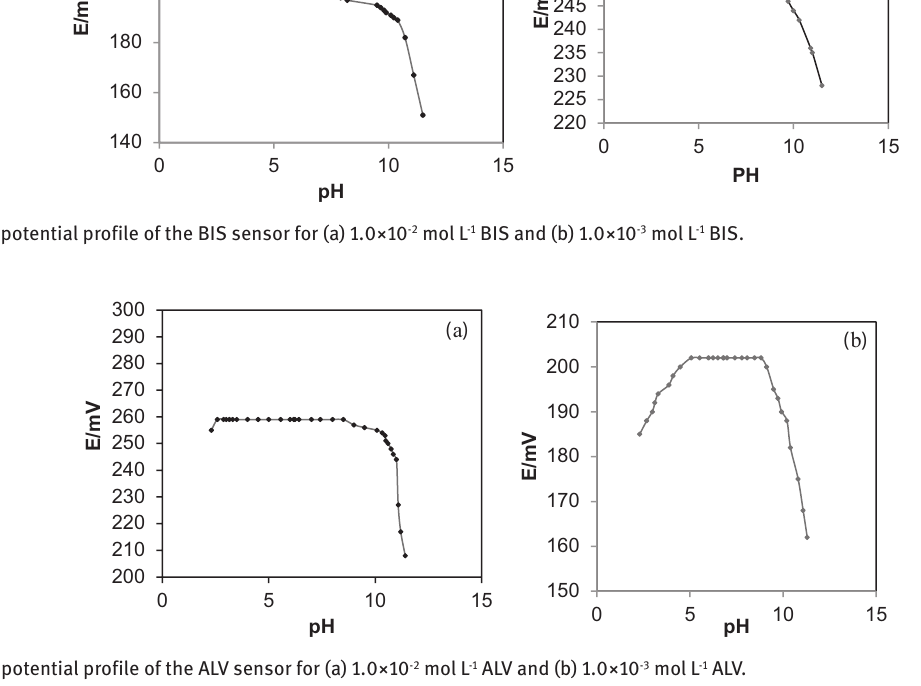
Figure 4: pH-potential profile of the ALV sensor for (a) 1.0×10 -2 mol L -1 ALV and (b) 1.0×10 -3 mol L -1 ALV.